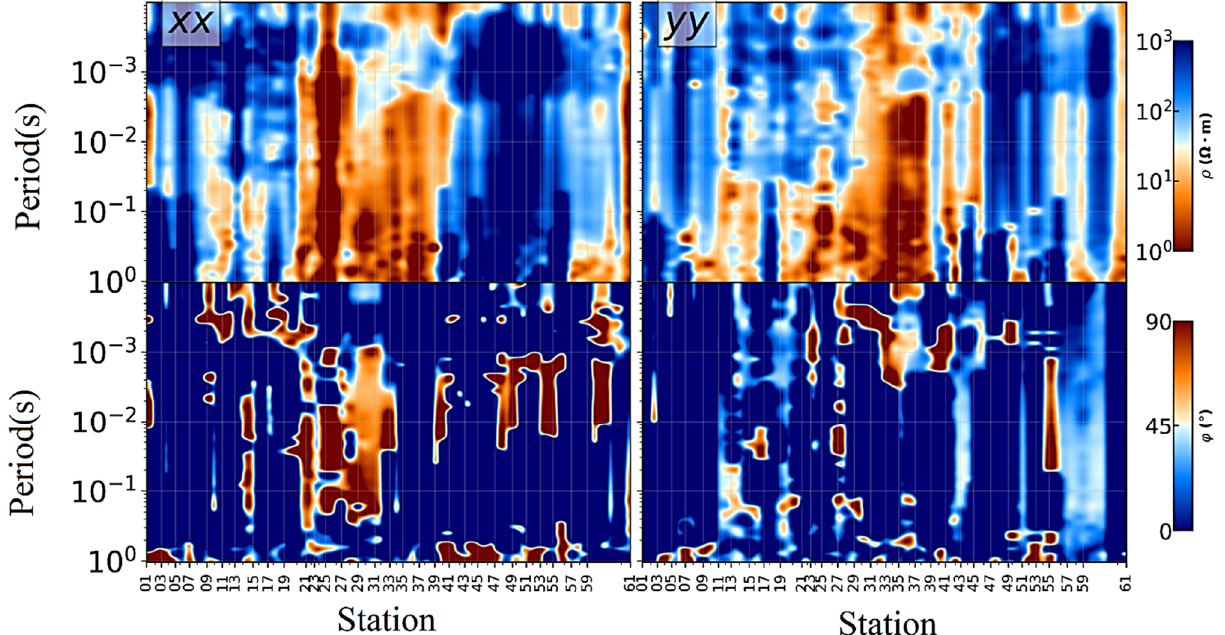
Figure 6. Apparent resistivity-phase pseudo-sections for Zxx and Zyy for an array of 61 stations across the Zhugongtang lead–zinc deposit. The upper panel shows resistivity and the lower panel represents phase, with Zxx as xx and Zyy as yy.